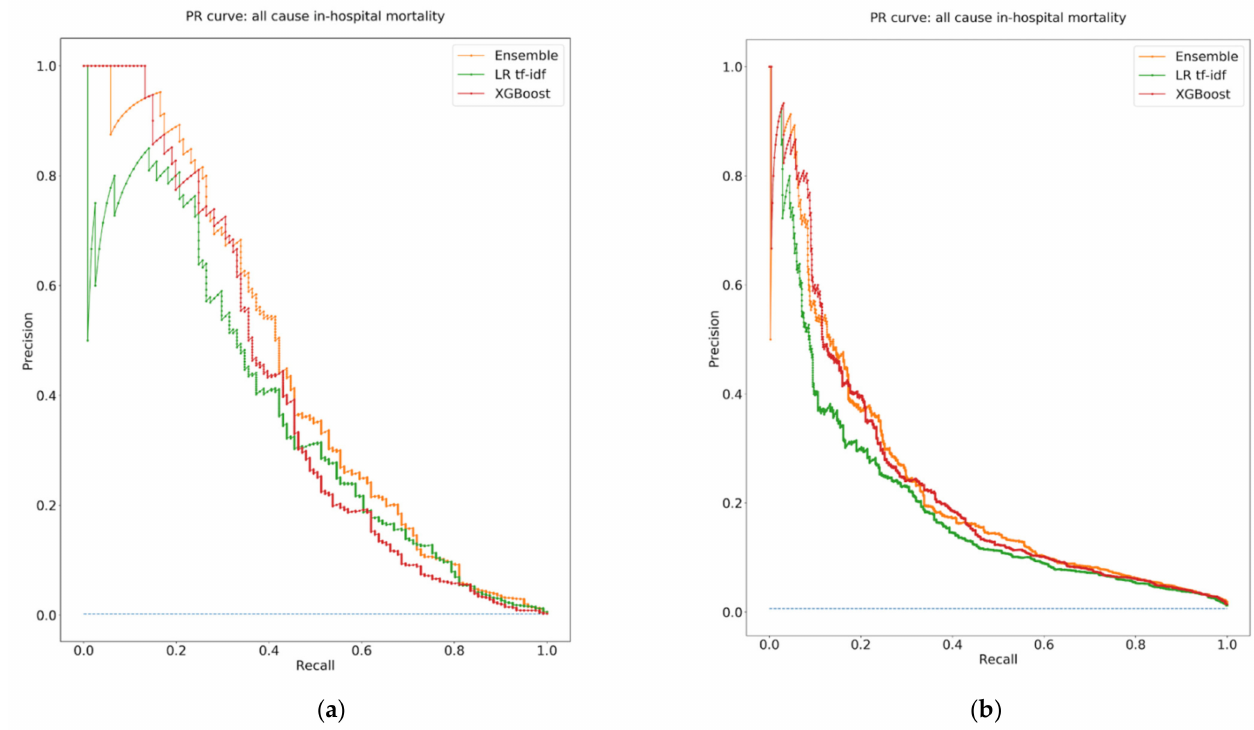
Figure 6. ( a ) Precision-Recall (PR) curve for in hospital mortality within 48 h ( b ) Precision-Recall (PR) curve for overall in-hospital